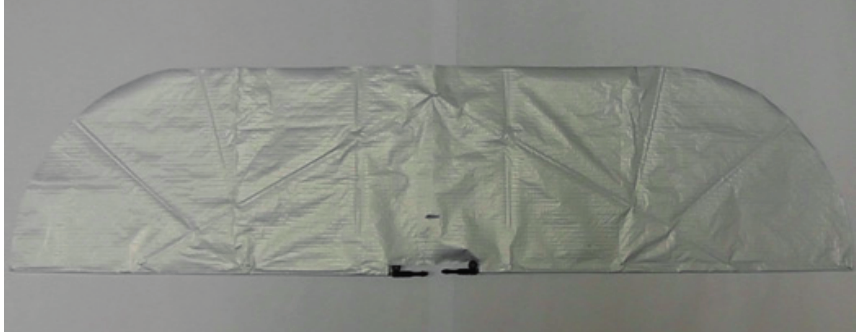
Figure 24. Orcon Flat Wing.